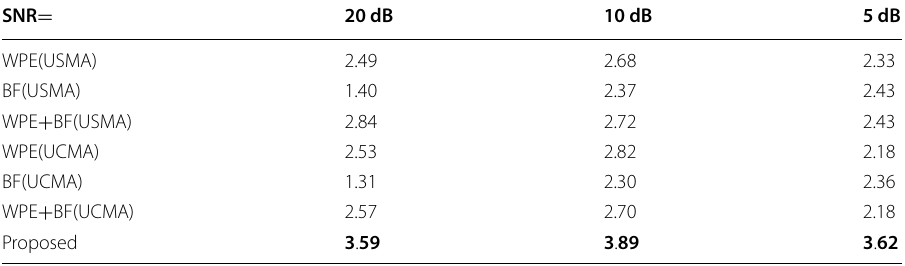
Boldface indicates the best score for each condition